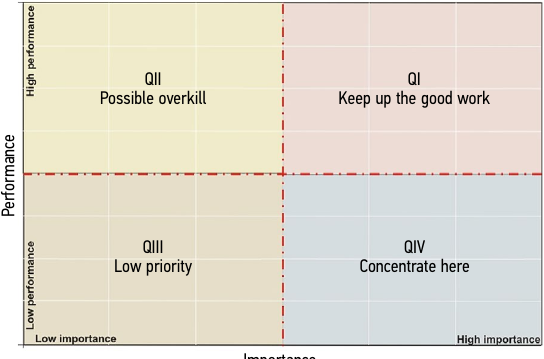
Fig. 1. Quadrants in